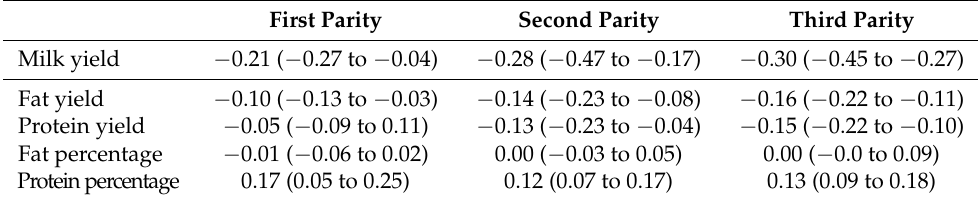
Table 3. Mean (range) genetic correlations between SCS and production traits in the first three parities of Iranian Holstein cows.